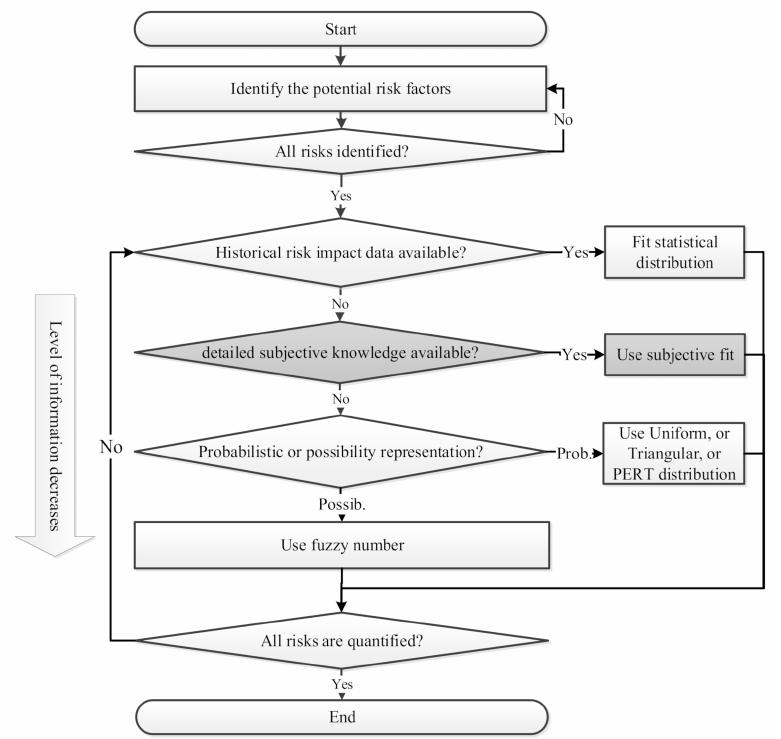
Figure 1. Levels of data available and accompanying methods used for input